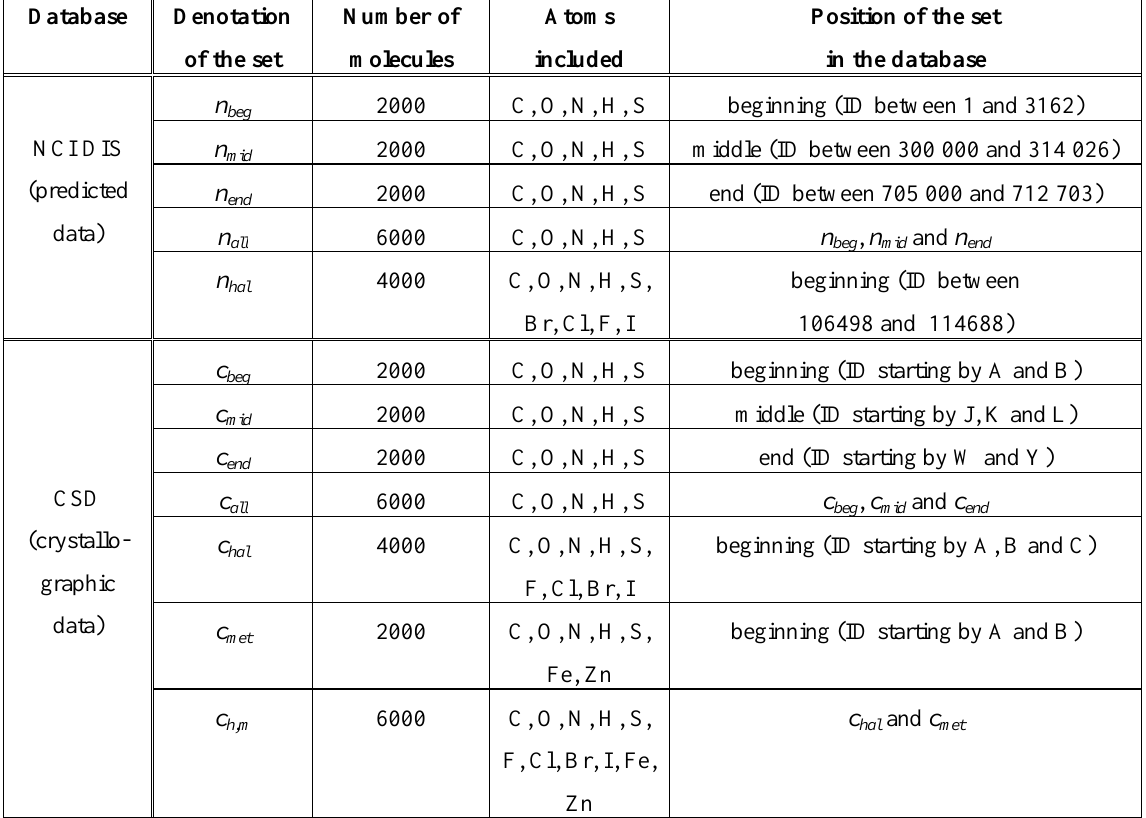
Table 1: Sets of molecules that were used as training and testing sets for the EEM parameterization. Database